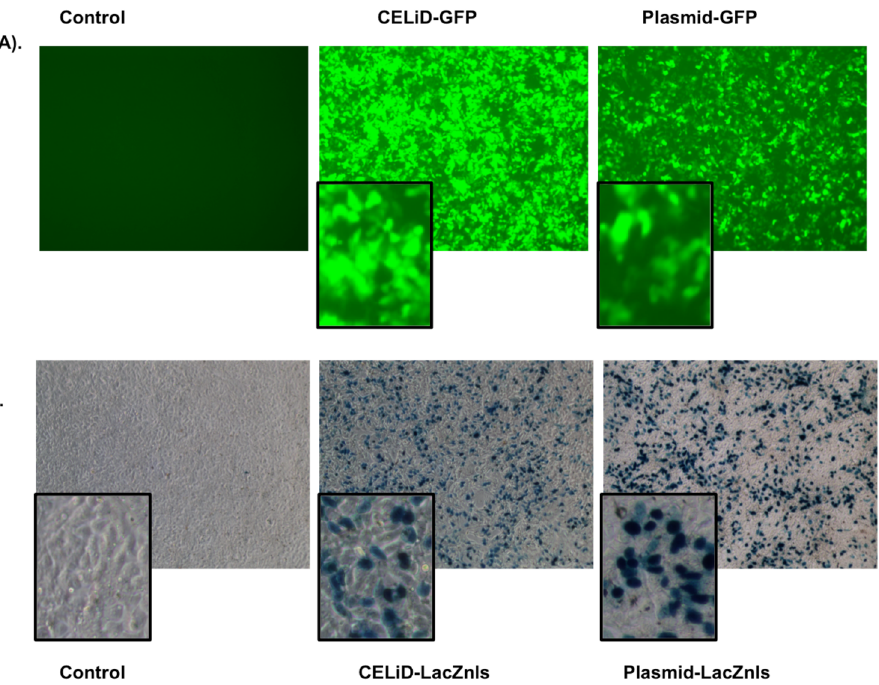
Figure 7. CELiD vector DNA expression invitro . (A) HEK 293 cells transiently transfected with CELiD-GFP DNA or plasmid pFBGR for green fluorescent protein (GFP) expression. Both DNAs harbor an identical gene expression cassette encoding GFP and were transfected using equivalent copy numbers. Images were taken at day 6 post-transfection. Magnification, 10x objective (with digitally-enlarged insert). (B) HEK 293 cells transiently transfected with equal amounts of CELiD-LacZnls DNA or plasmid pFB-CMV-LacZnls. Both DNAs harbor an identical gene expression cassette encoding b -galactosidase with a nuclear localization signal (LacZnls). X-gal staining of cells at three days post-transfection. Magnification, 10x objective (with digitally-enlarged